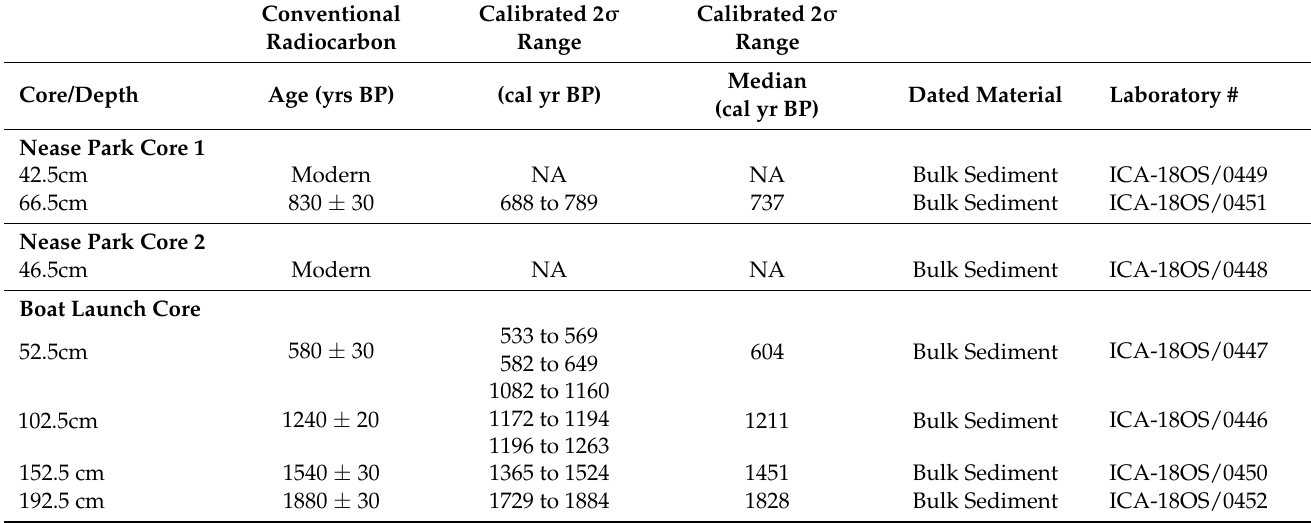
Table 3. Radiocarbon data are presented for the three cores. Sample depths are in cm below the ground surface and represent the mid-point of the sediment section sent for dating. The calibration procedures are described in the methods